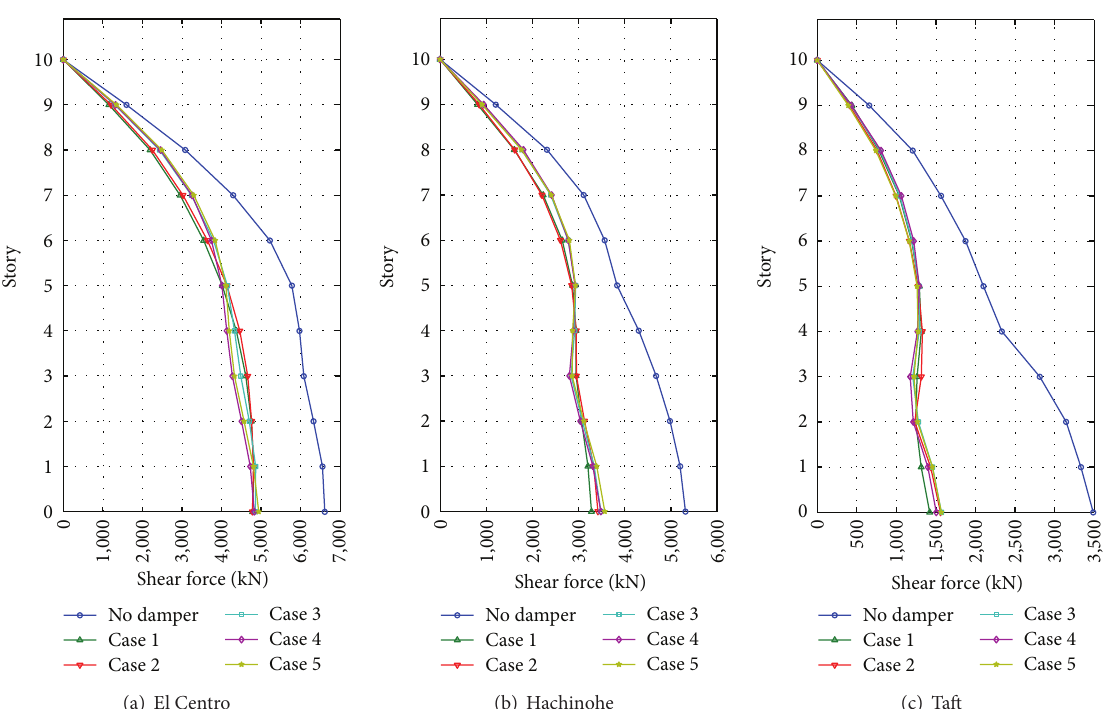
Figure 9: Comparative base shear forces subject to input